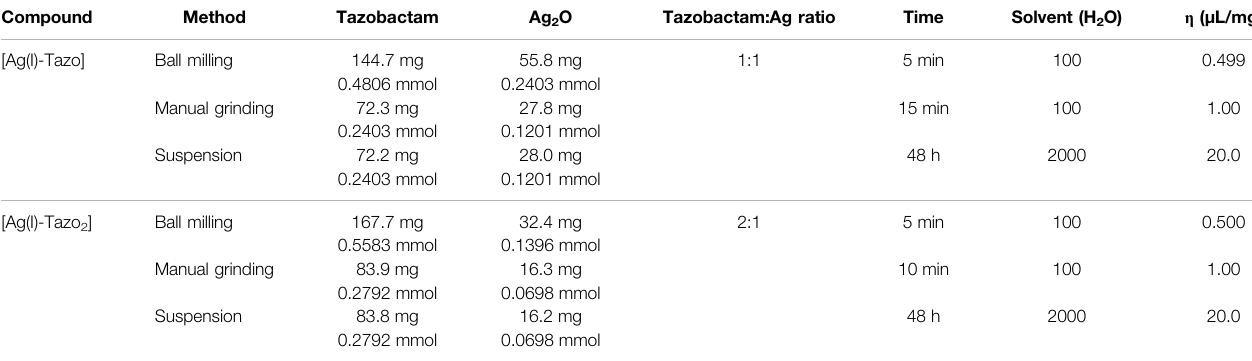
TABLE 3 | Experimental conditions for the synthesis of compounds [Ag(I)-Tazo] and [Ag(I)-Tazo 2 ].